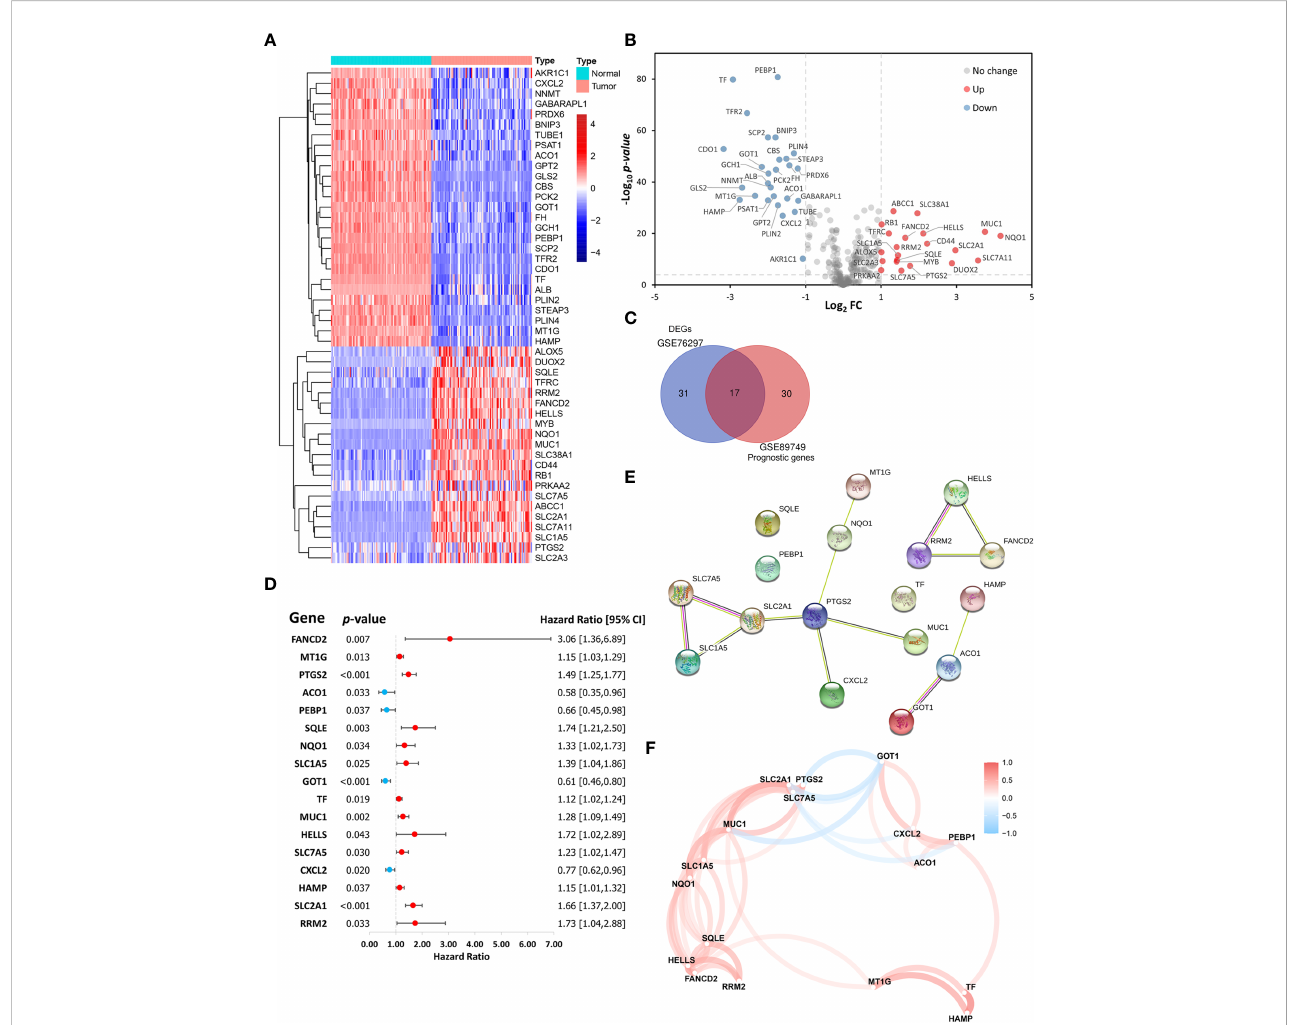
FIGURE 2 Identi fi cation of ferroptosis-related candidate genes. (A) Heatmap and (B) volcano plot showing the expression levels and distribution of differentially expressed genes (DEGs) in cholangiocarcinoma (CCA) tissues and normal tissues in the GSE76297 cohort. (C) A Venn diagram showing the intersection between DEGs and prognostic genes. (D) A forest plot showing the hazard ratios of candidate genes. (E) A protein-protein interaction (PPI) network of the candidate genes in the STRING database. (F) A correlation network of the candidate